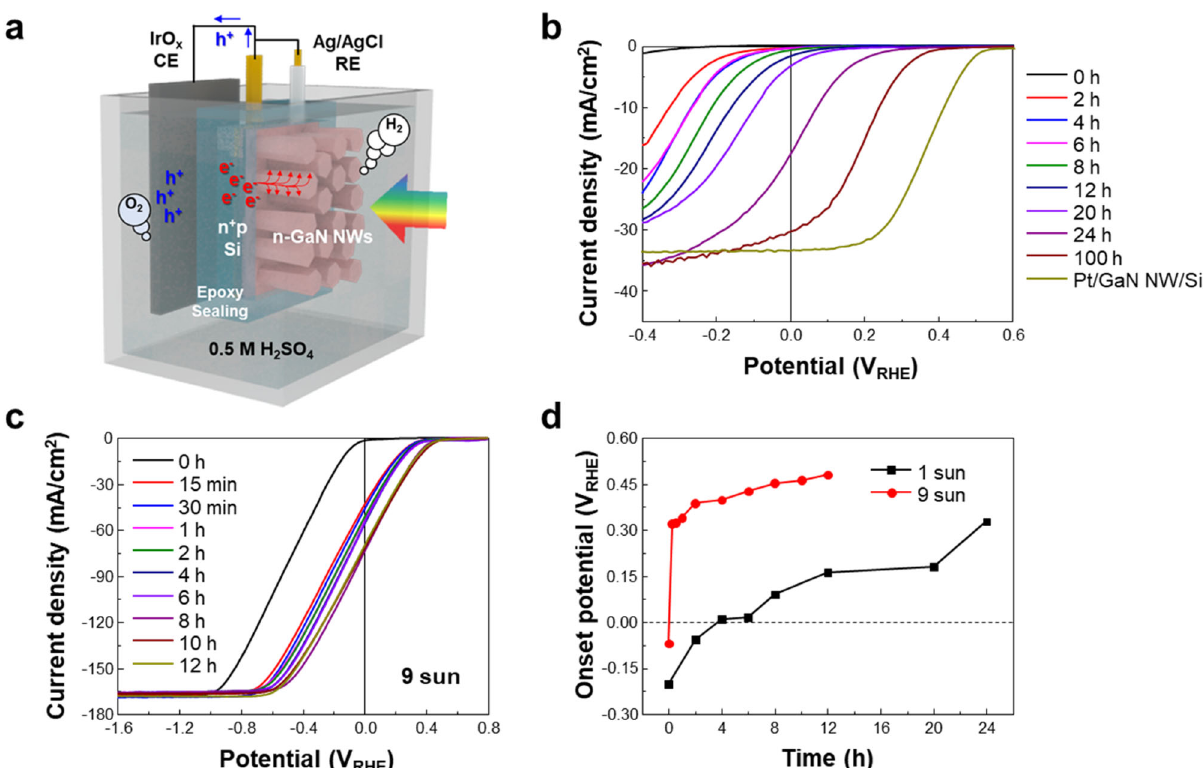
Fig. 1 | Photocathodes evaluated in a three-electrode con fi guration. a Schematic illustration of photoelectrochemical H 2 evolution reaction in a three- electrode con fi guration. GaN NW/Si photocathode, iridium oxide (IrO x ), and Ag/ AgCl were used as the working, counter, and reference electrode, respectively. b Linear sweep voltammetry (LSV) curves of the GaN NW/Si photocathode after